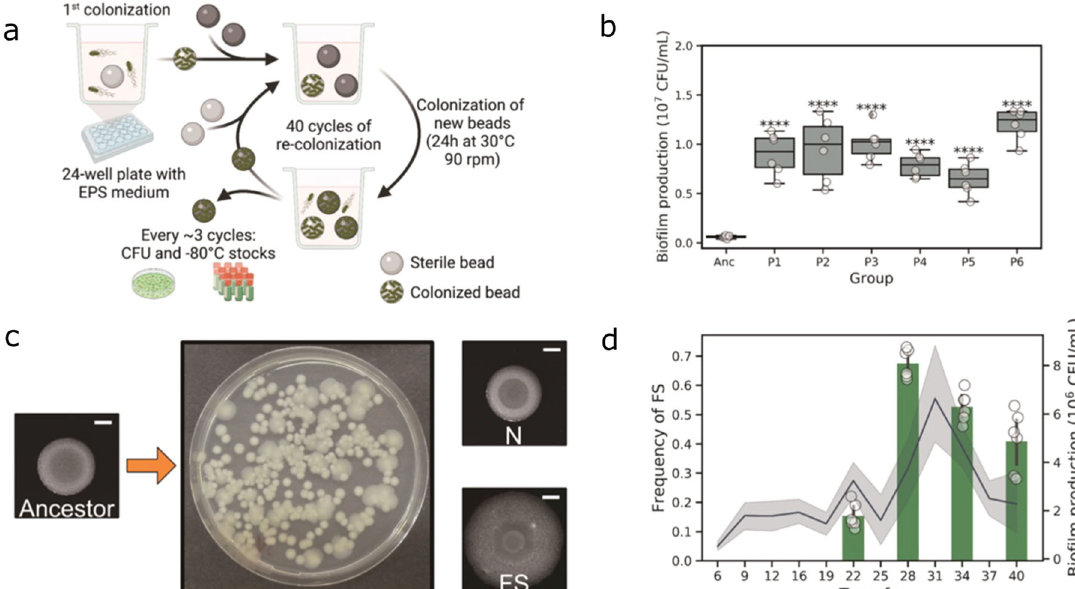
Fig. 1 Evolution of nylon bead-associated bio fi lms of Bt407 diversi fi ed into a distinct morphotype. a Schematic representation of the bead-based experimental evolution setup. b Enhanced bio fi lm productions were revealed by CFU analysis of all fi nal evolved populations compared with the ancestor ( n = 6 biologically independent samples). Boxes indicate Q1 – Q3, lines indicate the median, and bars span from max to min. Asterisks indicate signi fi cant differences between each group and the ancestor (**** p < 0.0001; One-way ANOVA followed by Dunnett ’ s multiple comparison tests). c Distinct colony morphotypes of the evolved variants were evidenced on the LB agar medium. N and FS indicate normal and fuzzy spreader morphotypes, respectively. Scale bars indicate 5 mm. d Bar plot represents the relative frequencies of the FS morphotype ( n = 6). Line plot represents the average bio fi lm productivity along with the experimental evolution. Error bars and shaded area indicate the standard error of the mean in the bar chart and line chart,